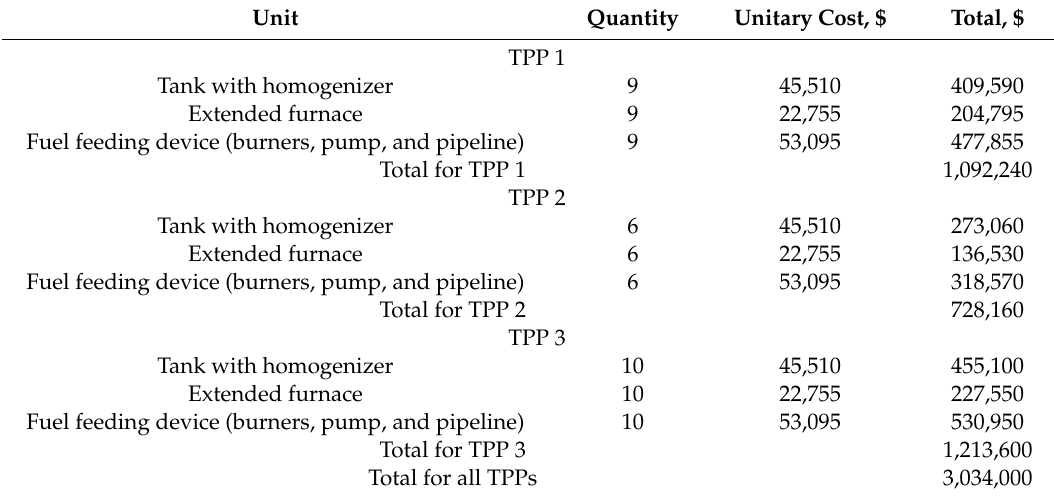
Table 11. Modernization costs of